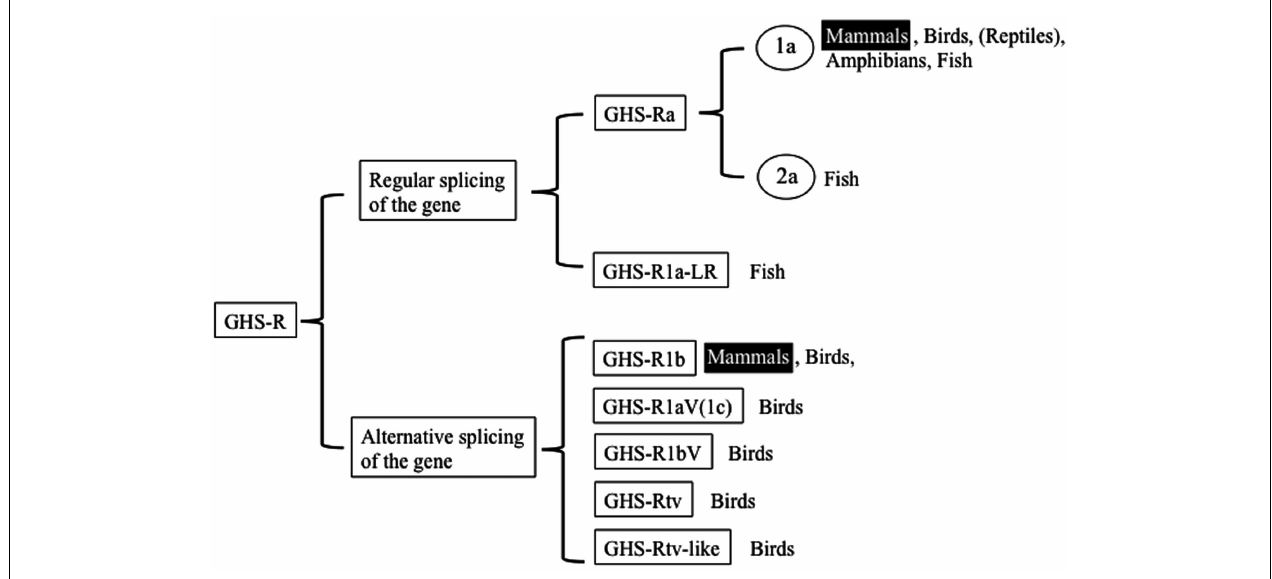
FIGURE 1 | Classification of ghrelin receptors . Receptors that exist in mammals are